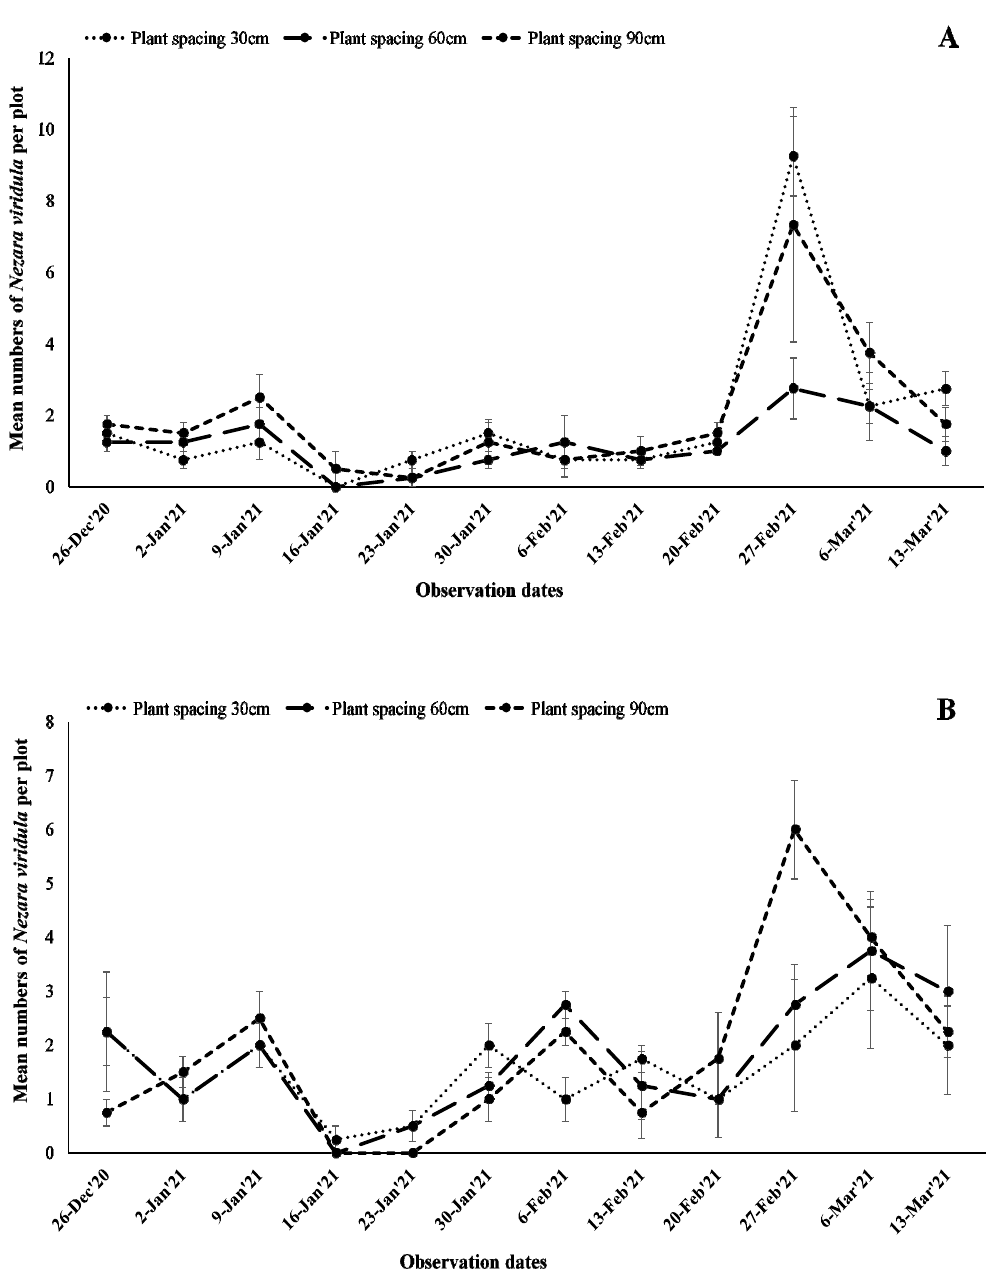
Figure 2. Temporal distribution of Nezara viridula within three plant spacings (30 × 50 cm, 60 × 50 cm and 90 × 50 cm) of two tomato varieties [Areenez F1 ( A ) and Tala F1 ( B )] (the mean of Nezara viridula /week ±